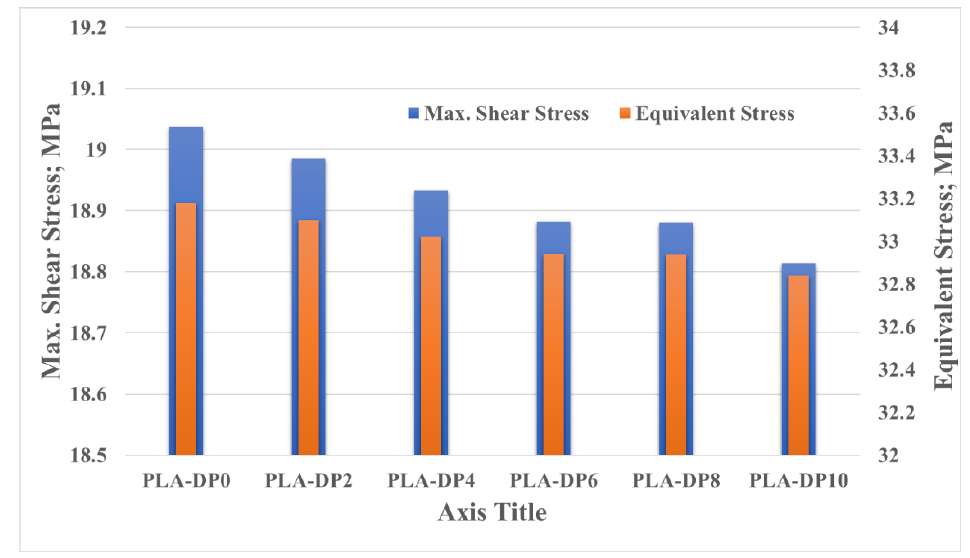
Figure 15. Finite element model of a hip joint with boundary condition, meshing, and contact stresses.